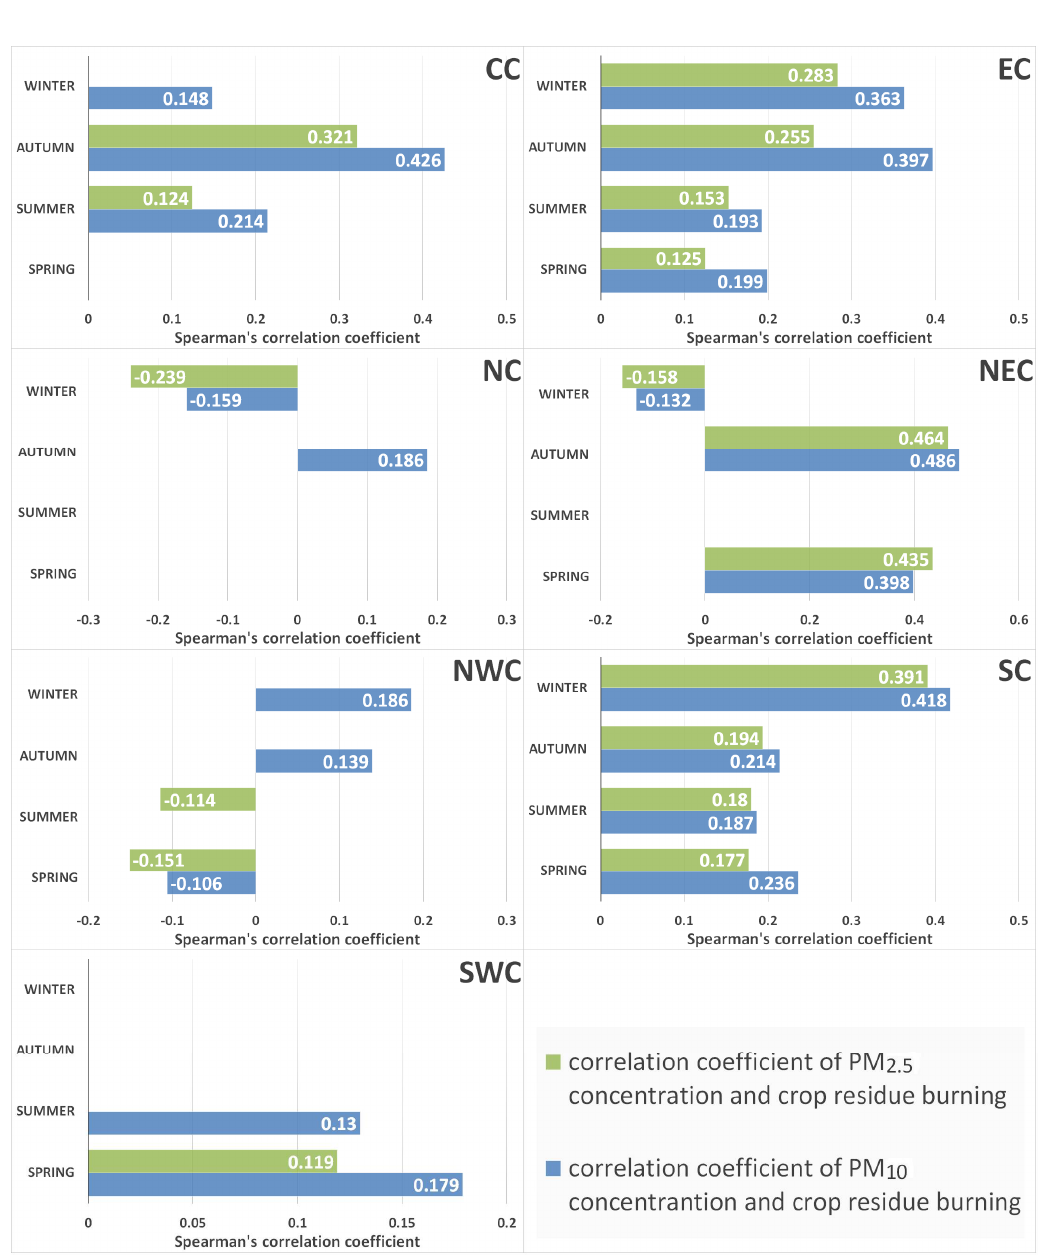
Figure 11. Seasonal variations of correlation coefficient between PM concentrations and crop residue burning among seven regions of China. burning among seven regions of